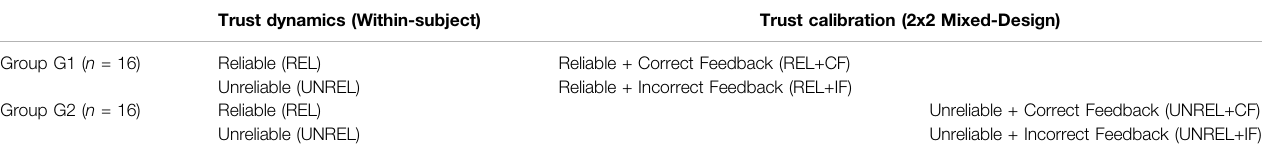
TABLE1| Experimentgroupsandconditions.Reliable:succeedswithallscrews.Unreliable:succeedswithnormalscrewsbutfailswithrustyones.CorrectFeedback:when thescrewisrusty,therobotsays “ ICan ” ifitwillsucceedand “ ICannot ” ifitwillfail.IncorrectFeedback:whenthescrewisrusty,therobotsays “ ICannot ” ifitwillsucceed and “ I Can ” if it will